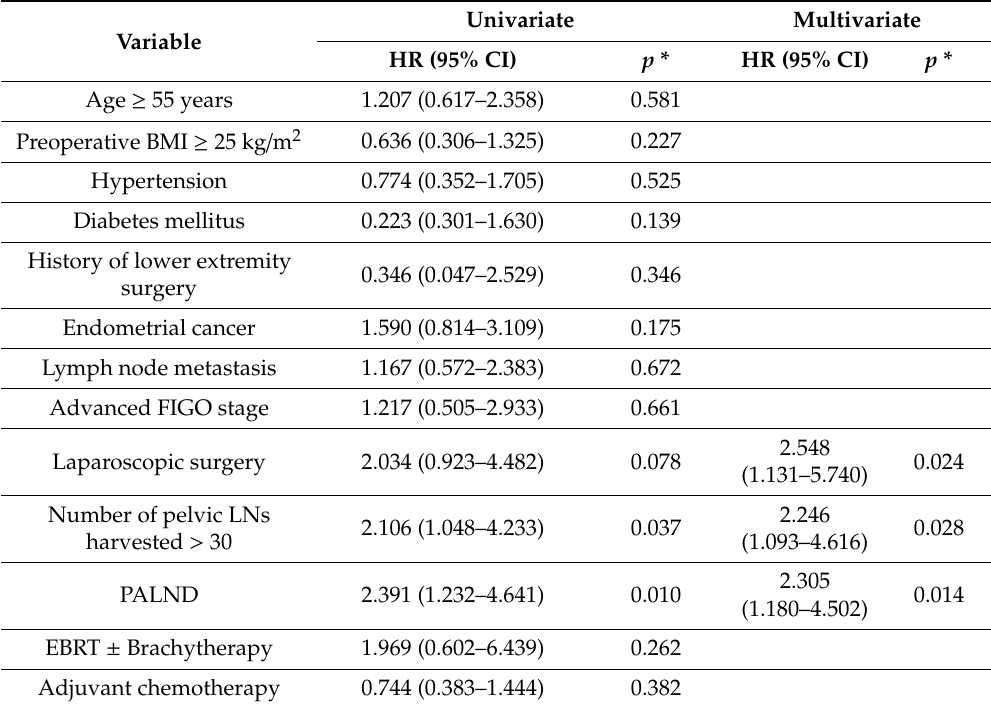
Table 2. Multivariate analysis of risk factors associated with lower extremity lymphedema.